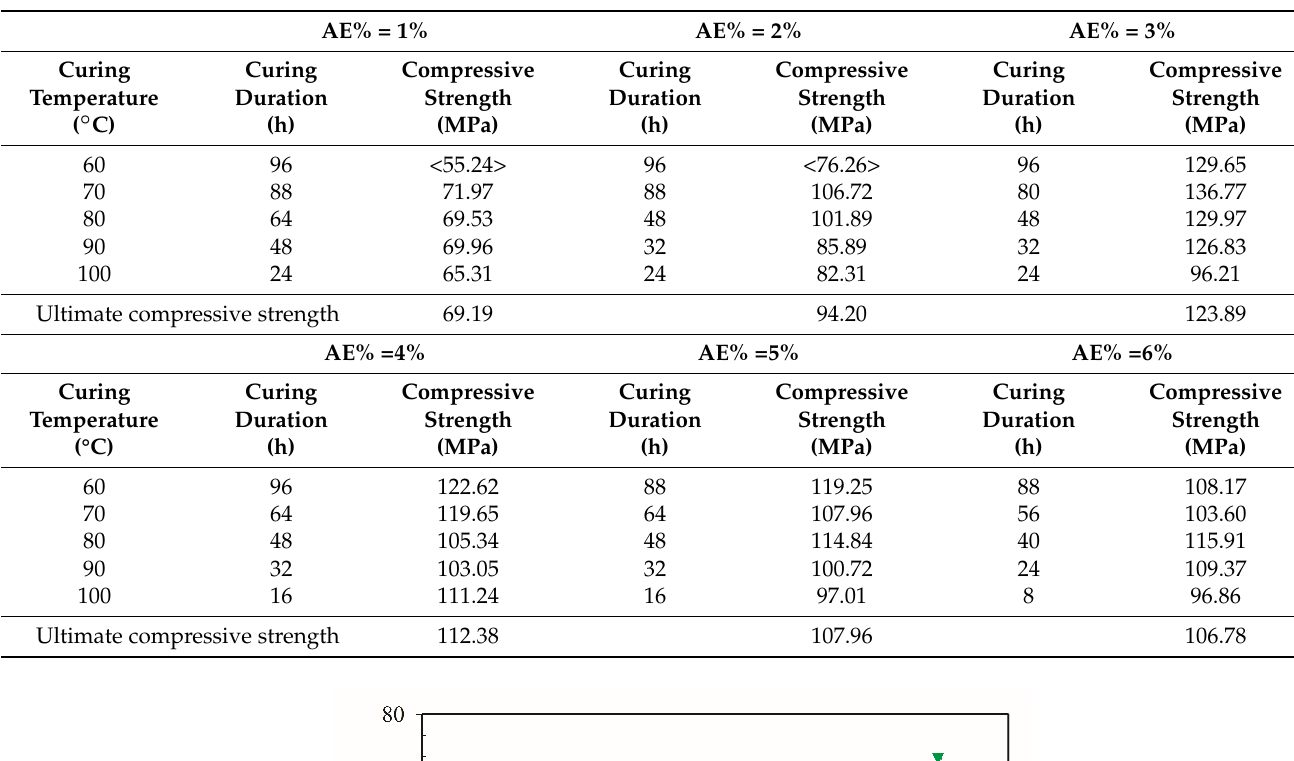
Table 3. Ultimate compressive strengths of the specimens under various curing temperatures when AE% = 1–6%.